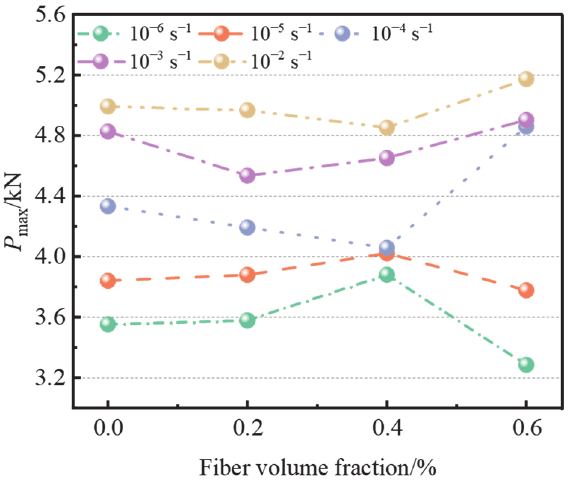
Figure 7. Peak loads under different fiber content.